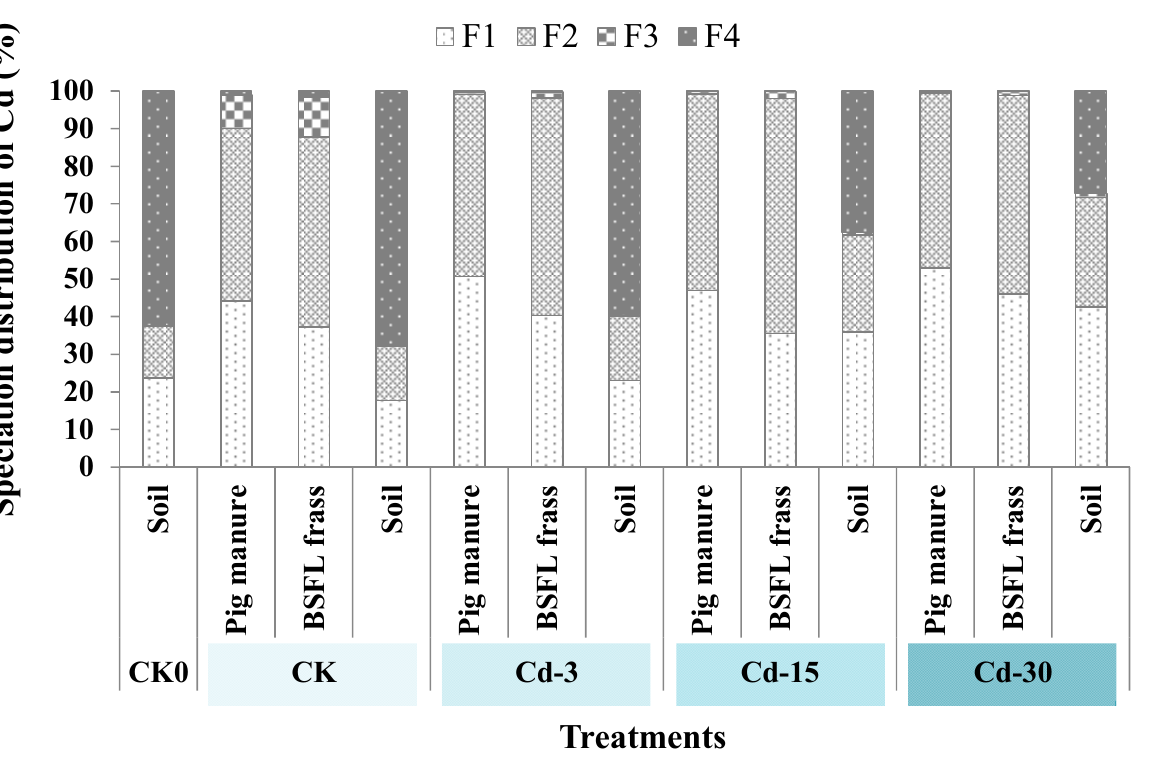
Figure 3. The changes in Cd speciation in soil, pig manure, and BSFL frass under different treatments. F1: weak acid-soluble fraction; F2: reducible fraction; F3: oxidizable fraction; F4: residual fraction.